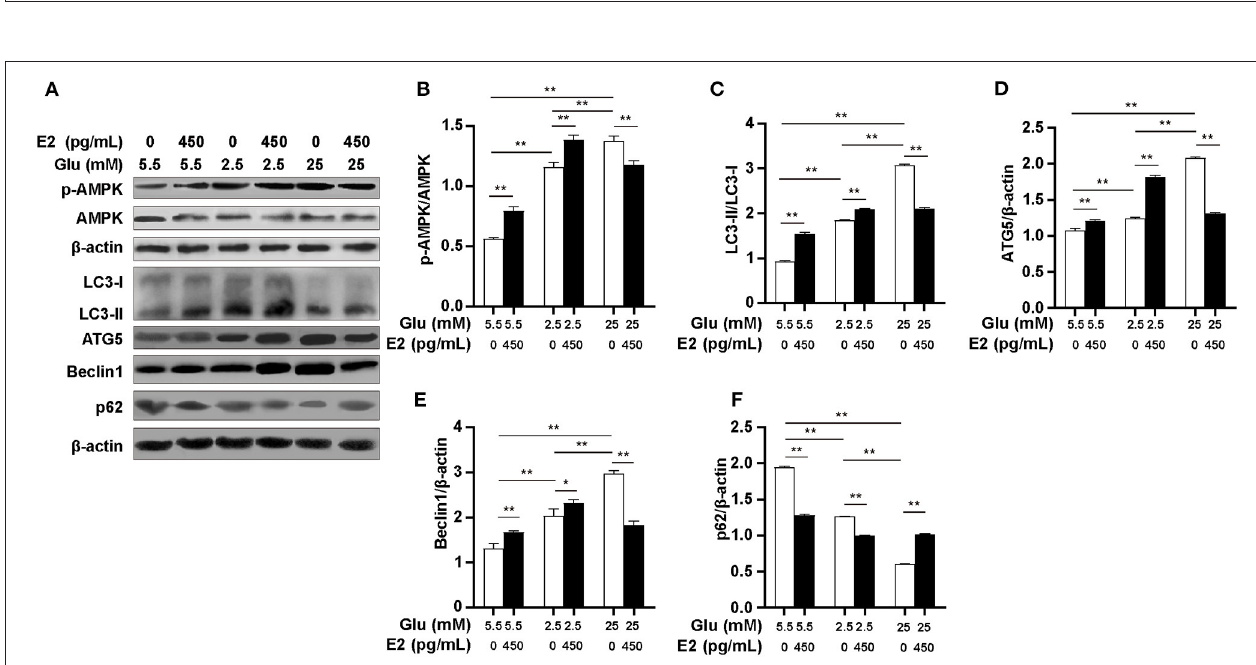
FIGURE 4 | E2 regulates glucose uptake and utilization by regulating the activities of HK and glucose transporters. PMNs were treated with LG, NG, HG, LG + EL, LG + EM, LG + EH, NG + EL, NG + EM, NG + EH, HG + EL, HG + EM and HG + EH for 6h. (A–D) HK activity was measured by the biochemical method. (E–H) The expression of GLUT1, GLUT4 and SGLT1 were detected by WB, and β -actin was used as an internal control. The results are shown as the mean ± SD ( n = 3). The significance of the difference was analyzed using the t -test. * P < 0.05, ** P < 0.01.